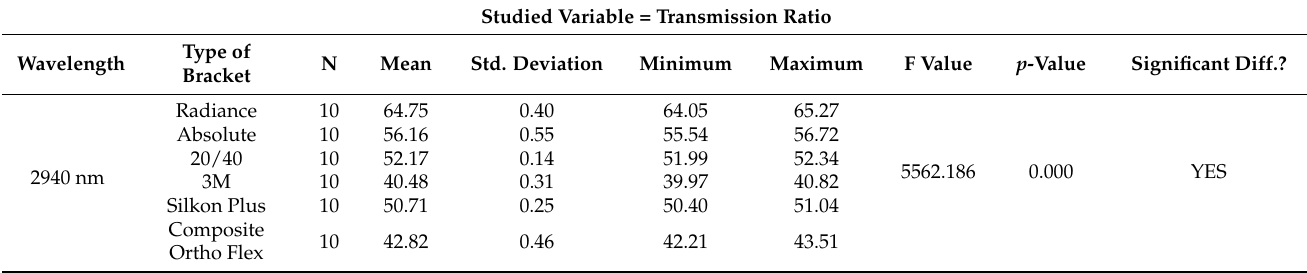
Table 3. Results of the one-way ANOVA test to determine whether there were significant differences in the transmission ratio values between the different bracket groups at a 2940 nm